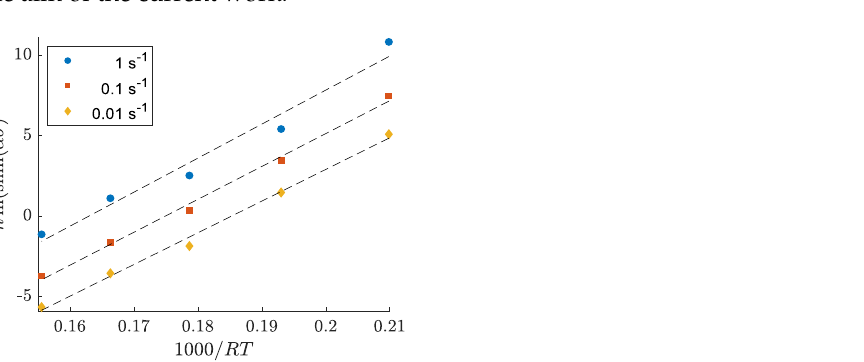
Figure 5. The linear plots for determining Q . For this plot, α and n are considered as functions of ε .